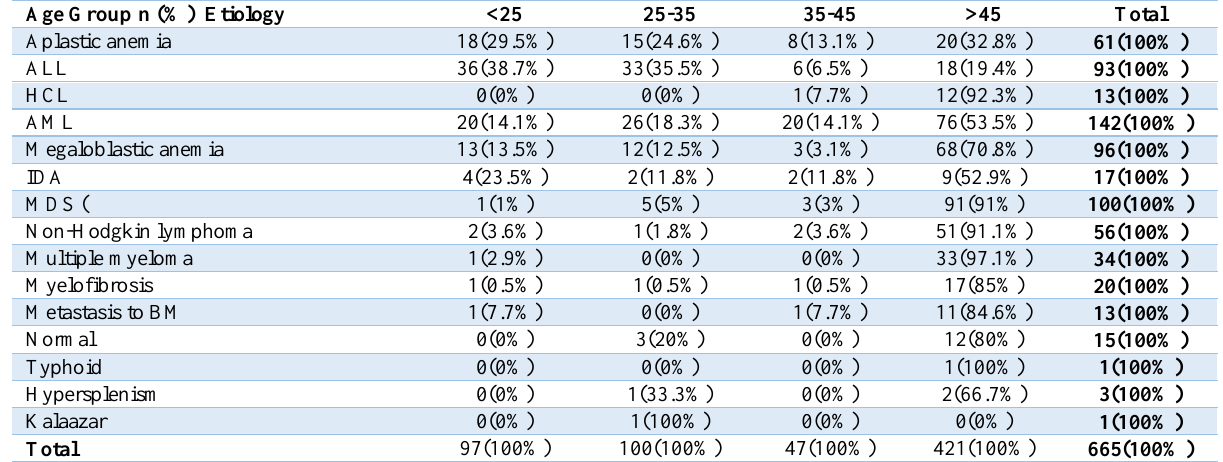
Table2. The Frequency of Pancytopenia Etiologies According to Age